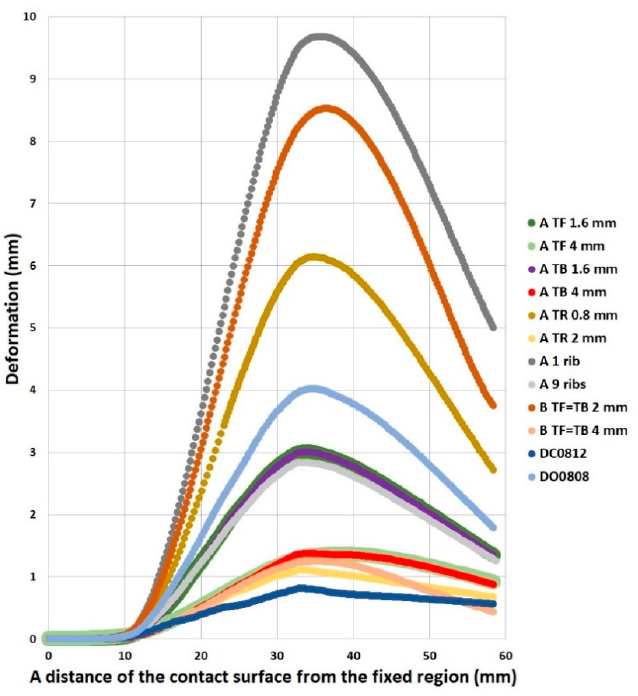
Figure 11. Comparison of all structures according to deformation under load 5 N.